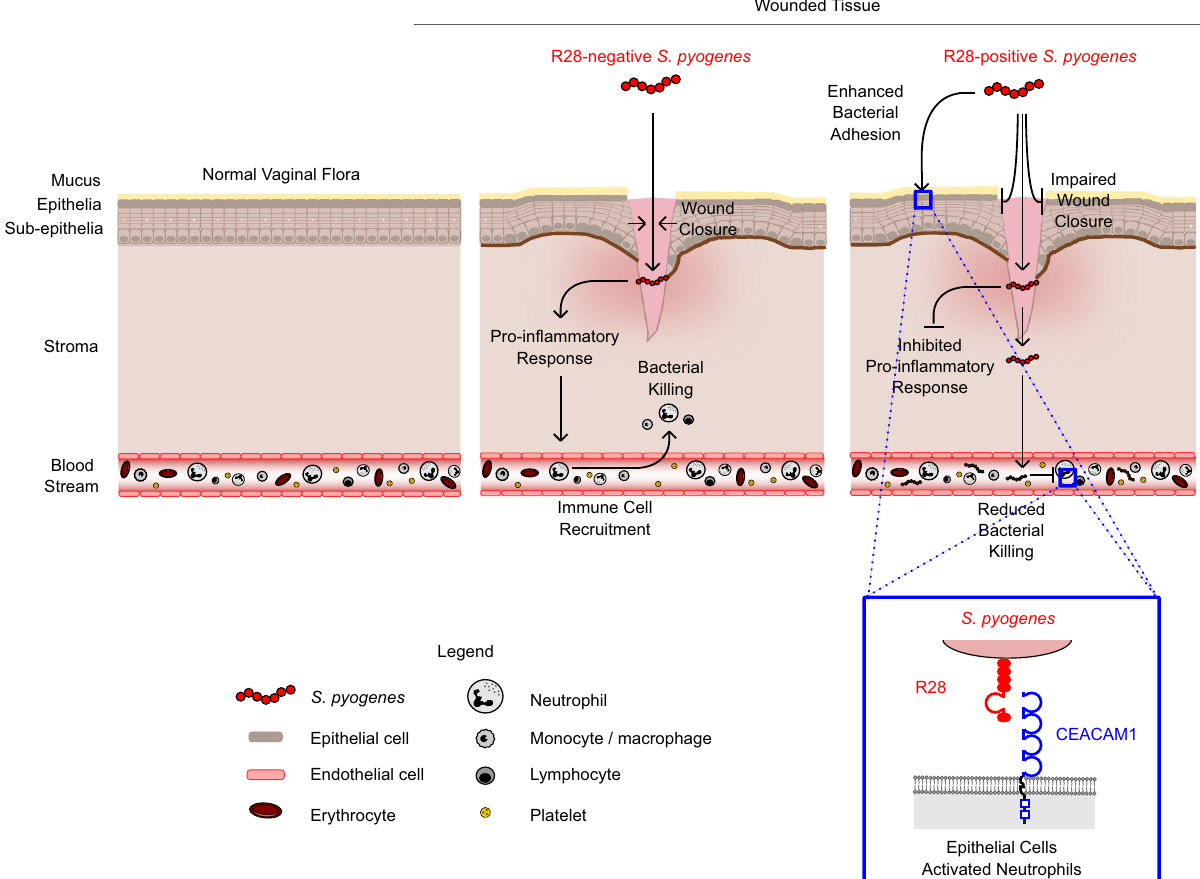
Fig.6|ModelfortheroleofR28-CEACAM1interactionin S.pyogenes puerperal sepsis pathogenesis. The intact vaginal epithelium (left panel) is rarely colonized by S.pyogenes ,butwoundsintroduced duringchildbirthprovideopportunitiesfor R28-expressing S. pyogenes to invade the mucosal tissue (right panel). Interaction of R28 with CEACAM1, present on the apical surface of the epithelial cells, impairs wound repair, and suppresses the proin fl ammatory immune response. This